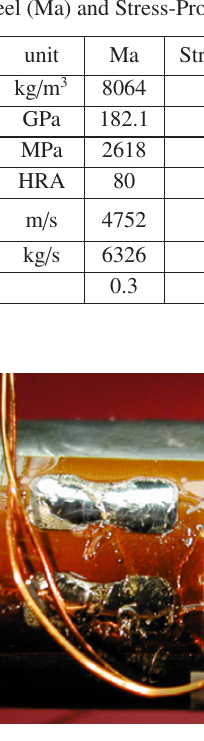
Fig. 3. Thin wires soldered to the strain gage’s tab after failure.